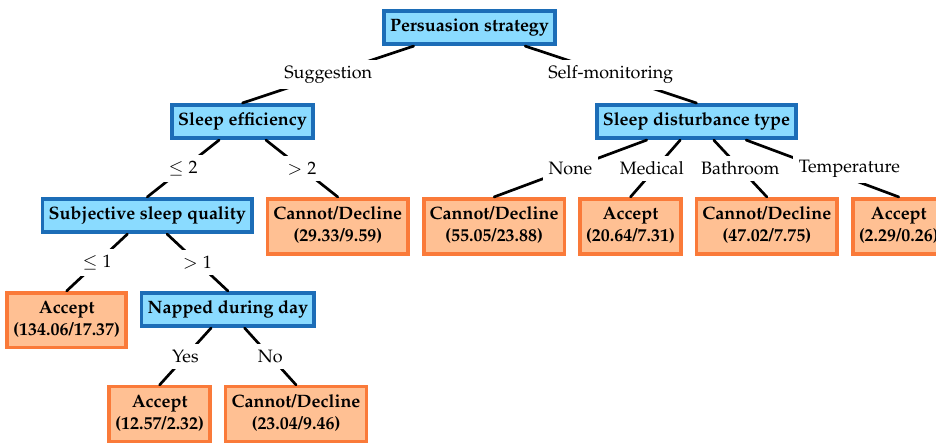
Figure 4. Decision tree for predicting user acceptance of a sleep quality coaching